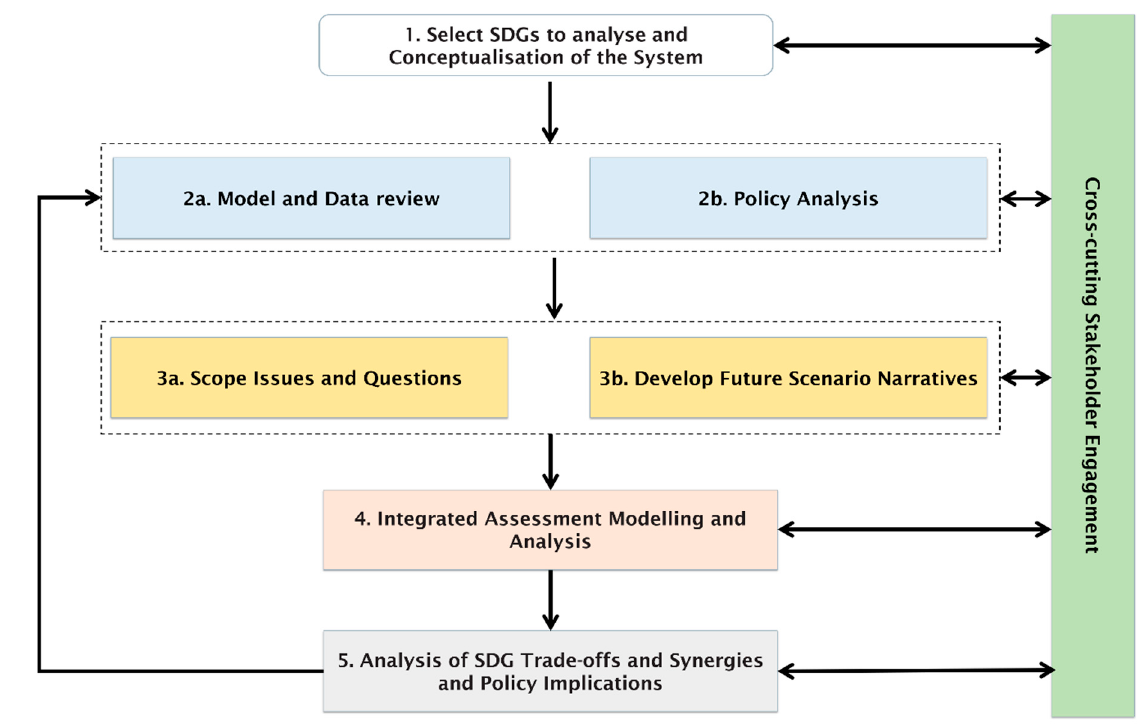
Figure 2. Steps of the integrated assessment approach used to gain system-specific knowledge of human–natural processes and their interlinkages for the purpose of assessing interactions in specific Sustainable Development Goals (SDGs).